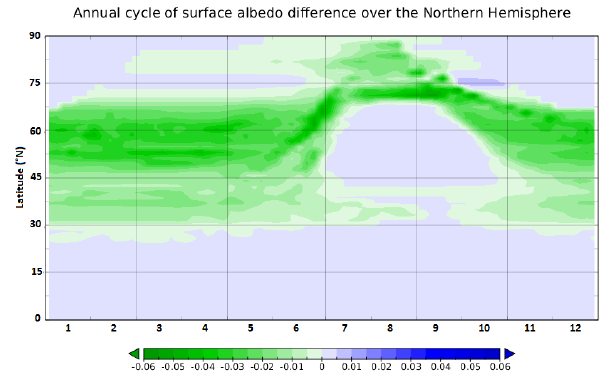
Fig. 3. Zonally-averaged annual cycle of the difference in surface albedo (EXT-CTL) over the Northern Hemisphere during the 500th year of the climate model simulation. On the abscissa, months are displayed from January to December according to their numerical order.